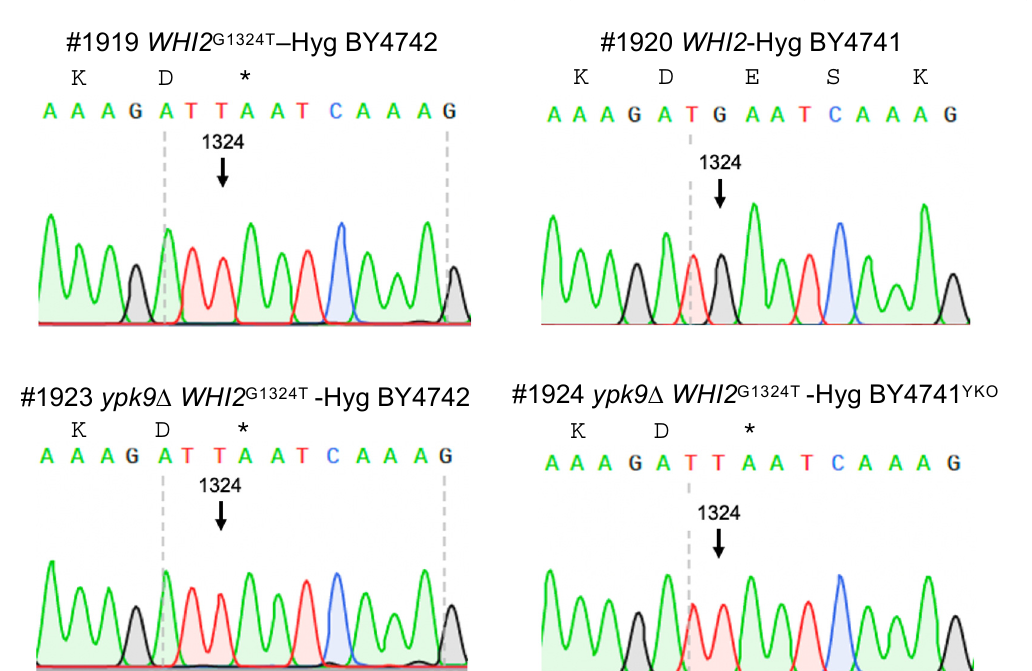
Figure 3. Sequence confirmation of engineered WHI2 variants. A hygromycin cassette was fused to WHI2 or its variant containing a stop codon at position 1324 ( WHI2 G1324T ) and used to replace the endogenous version of WHI2 in BY4741 COM , BY4742, and YKO collection’s ypk9 ∆ in BY4741 YKO . DNA sequencing was used to confirm the replacement. The asterisk represents the stop codon. Numbers with a hashtag represent the laboratory strain identification number.